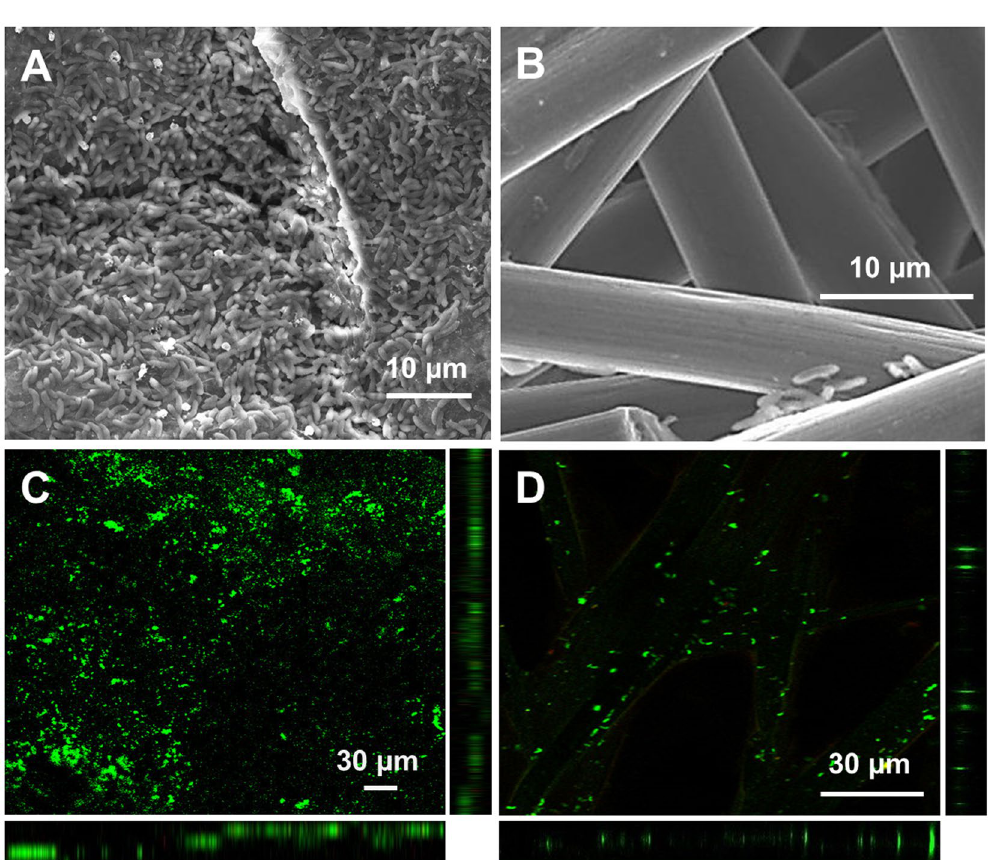
Figure 3. SEM and CLSM images of ( A , C ) a freestanding RGO paper cathode and ( B , D ) a carbon paper cathode in a S. ovata -driven MES